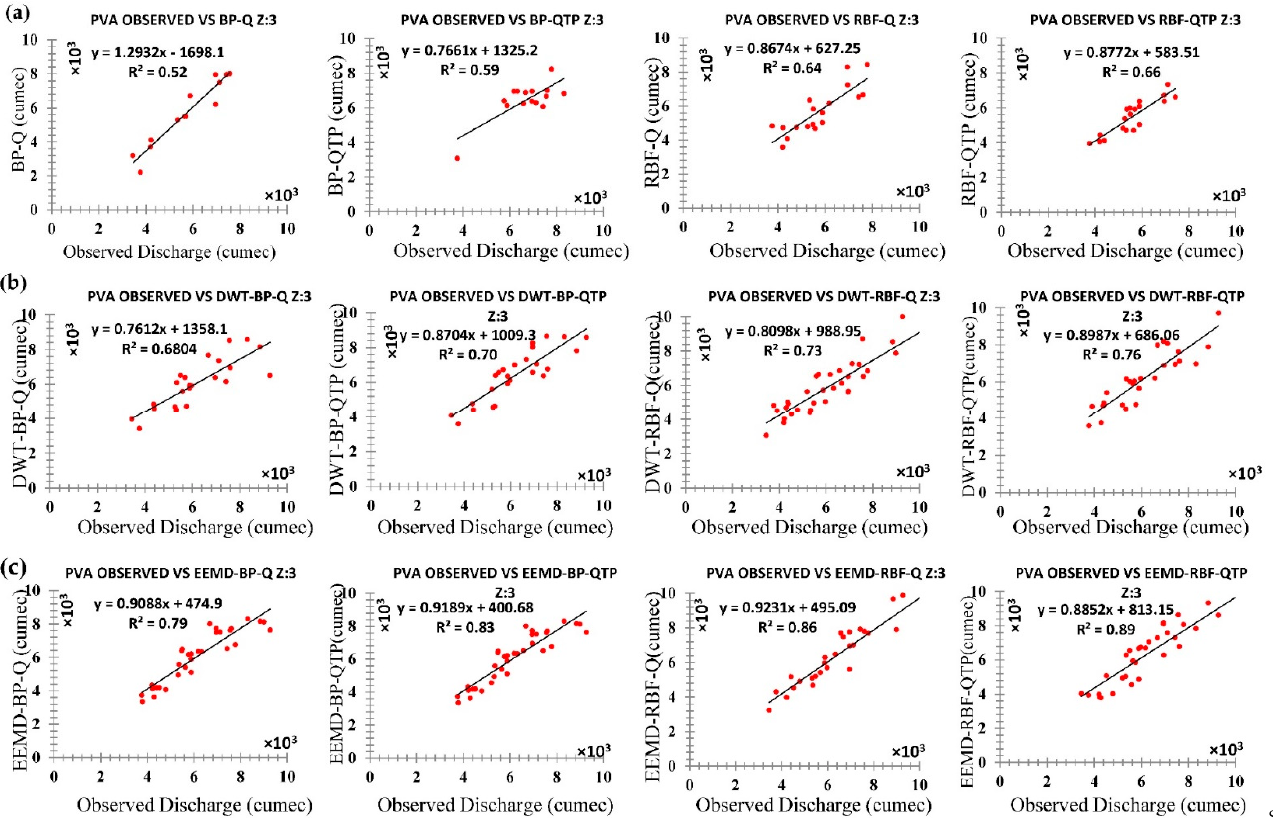
Figure 19. Monthly streamflow estimations for peak values during the flood season Zone Three ( a ) OBS VS ANN (Q & QTP) Inputs, ( b ) OBS VS ANN-DWT (Q & QTP) Inputs and, ( c ) OBS VS ANN-EEMD (Q & QTP) Inputs.